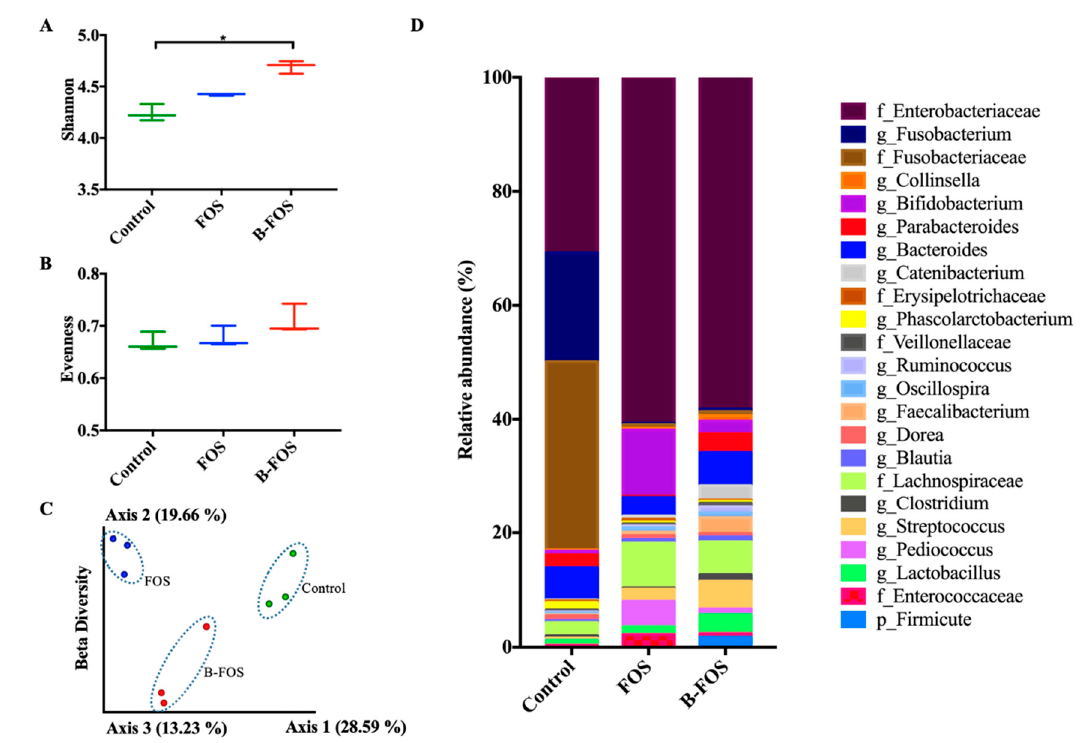
Figure 5. Comparison of diversity indices amongst groups after 24 h fermentation. Alpha diversity of microbial communities are shown as richness ( A ) and evenness ( B ). ( C ) Beta diversity analyzed by Jaccard. ( D ) Average relative abundance at the genus level. Taxa with relative abundance below 0.5% were excluded prior to analysis. Significance was accepted at * p < 0.05 ( n = 3).